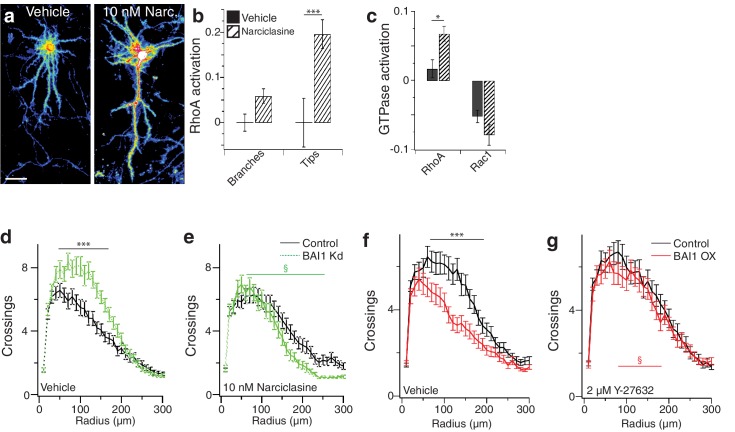
Verification of narciclasine function in neurons and Sholl analyses with RhoA manipulation.(a) Representative image of hippocampal neurons expressing Raichu RhoA and treated with DMSO (Vehicle) or 10 nM narciclasine (10 nM Narc.) 1 hr after treatment. (b) Summary data for changes in RhoA activation during the 1 hr. incubation. (c) Summary data for Cos-7 cells expressing Raichu-RhoA or Raichu-Rac1 before (solid bars) or 20 min after (hatched bars) after treatment with 20 nM narciclasine. (N = 3, n = 20–40) d) and e) Summary data of Sholl analyses in vehicle-treated (c) and narciclasine-treated (d) control (black) and BAI1 Kd (green) neurons. Total number of neurons is the same as for Figure 4a–e. (f) and g) Summary data of Sholl analyses in vehicle-treated (e) and Y-27632-treated (f) control (black) and BAI1 OX (red) neurons. Total number of neurons is the same as for Figure 4f–j. (***p<0.001, §p<0.001 (green) between the two BAI1 Kd curves (green) in panels d and e, §p<0.01 (red) between the two BAI1 OX curves (red) in panels f and g) Detailed statistics are found in Figure 4—figure supplement 1—source data 1.10.7554/eLife.47566.031Figure 4—figure supplement 1—source data 1.Statistical summary for Figure 4—figure supplement 1: ANOVA and key Tukey post-hoc tests and N and n values for Figure 4—figure supplement 1b–g.